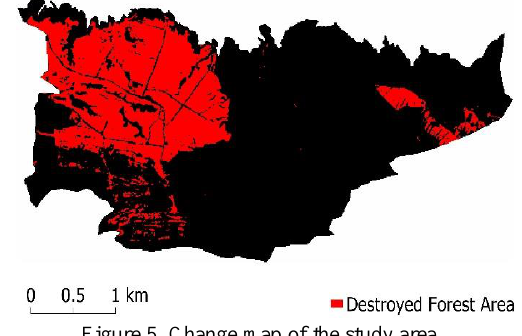
Figure 5. Change map of the study area.